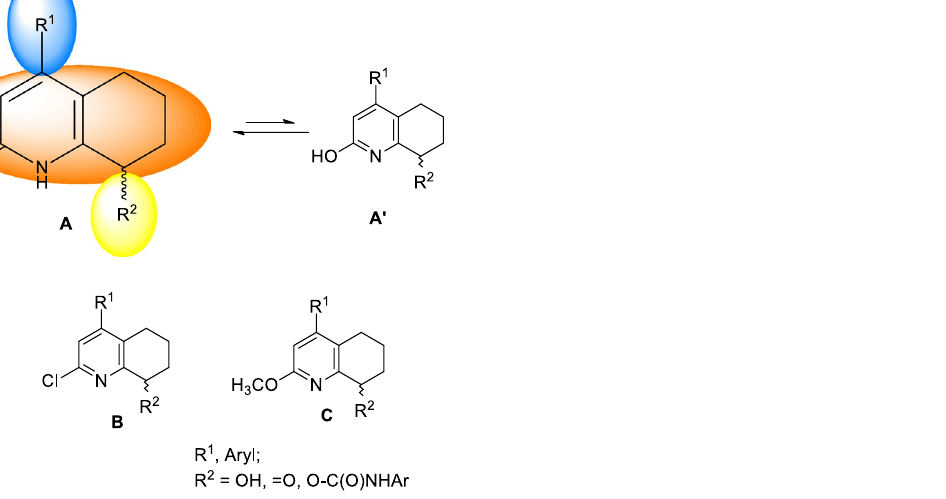
Figure 2. Structures of designed